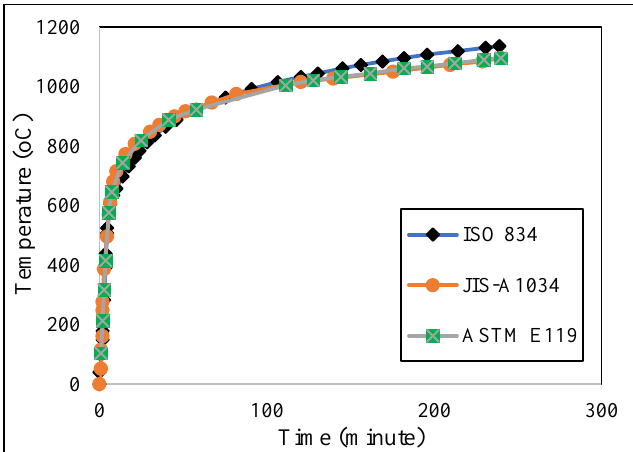
Figure 3. Standard fire curves.